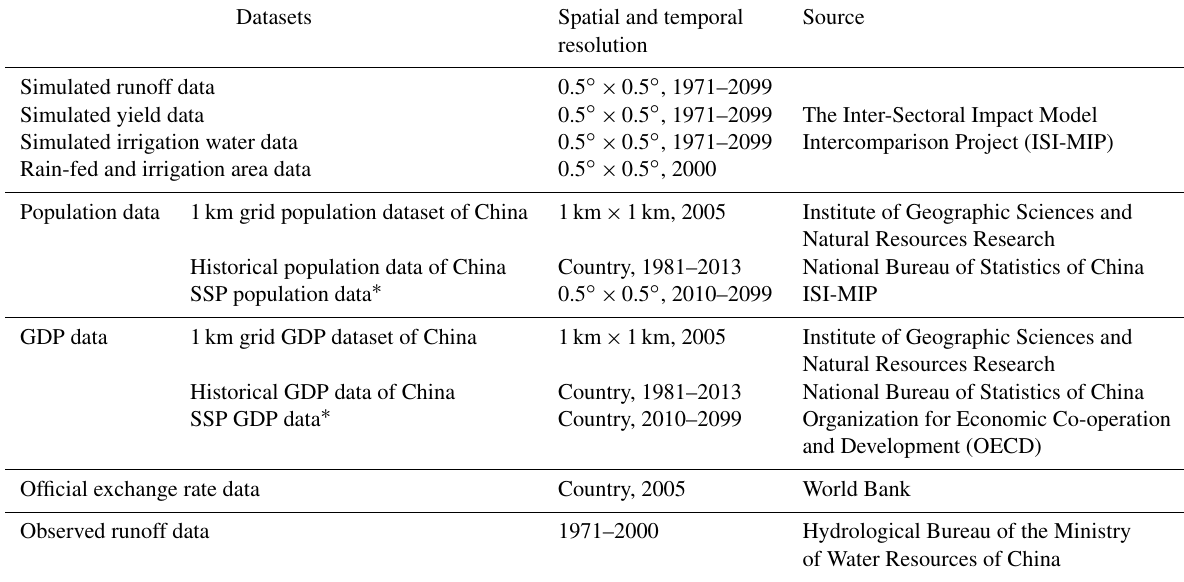
Table 2. Datasets used in this